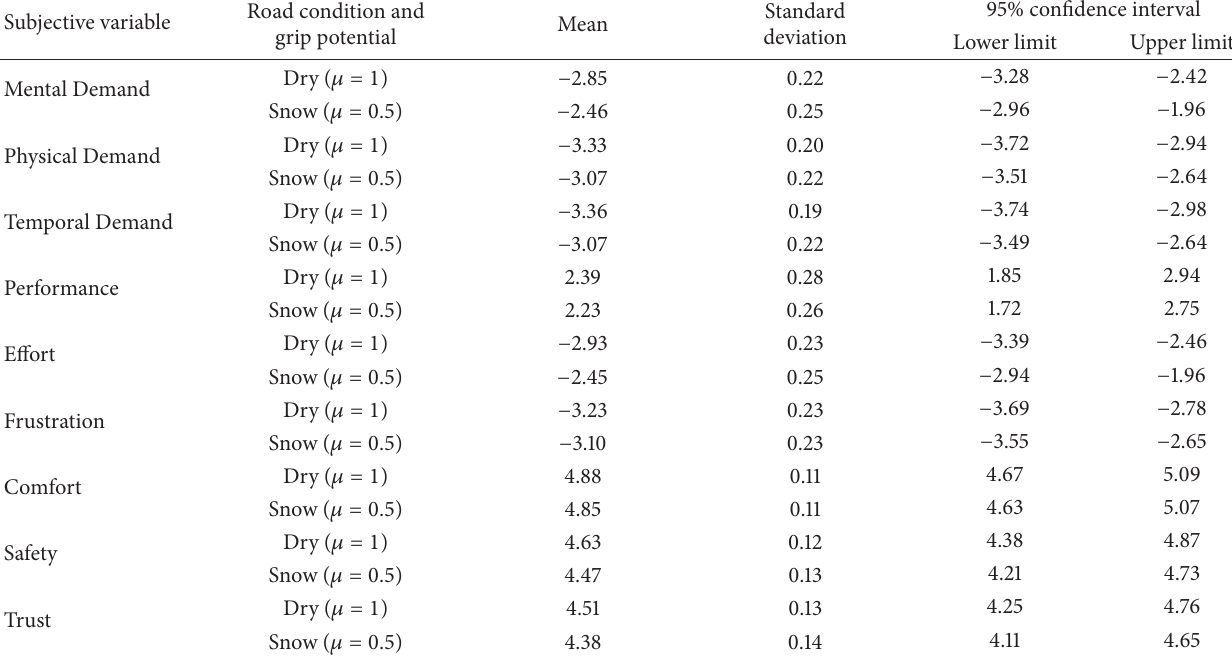
Table 3: Drivers’ self-ratings of workload, comfort, safety, and trust related to driving with the ACC on dry and snowy roads with various grip potentials ( 𝑁 = 96